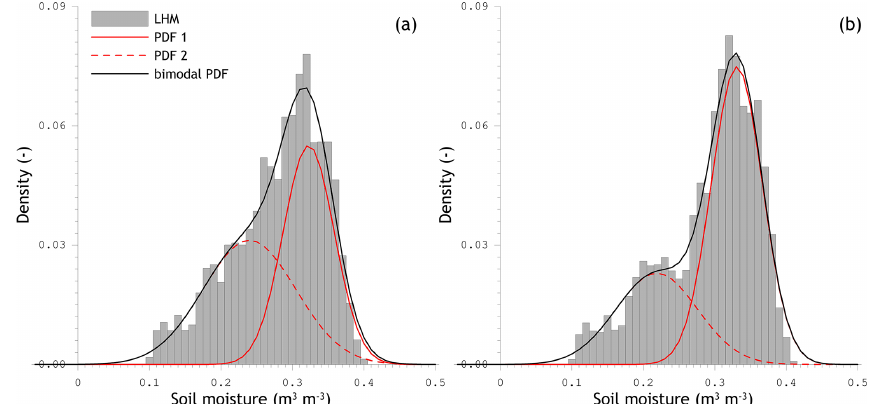
Figure 7. Density of soil moisture estimated from LHM simulations (bin size 0.01m 3 m − 3 ) and calculated using a weighed sum of two normally distributed pdfs. Panel (a) shows the density for reference pixels 3306 and 3606 and panel (b) that of reference pixel 4371.